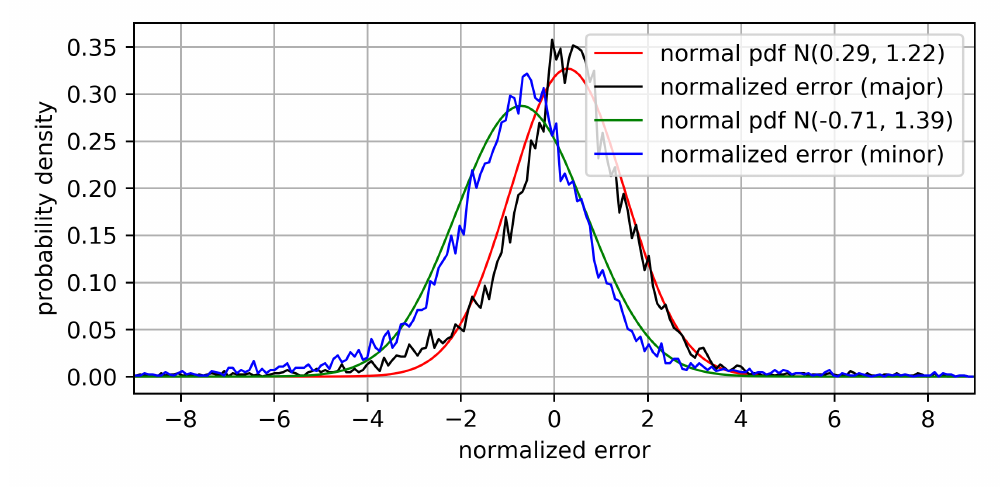
Figure 8. Experimental probability function of normalized translation vector estimation error by